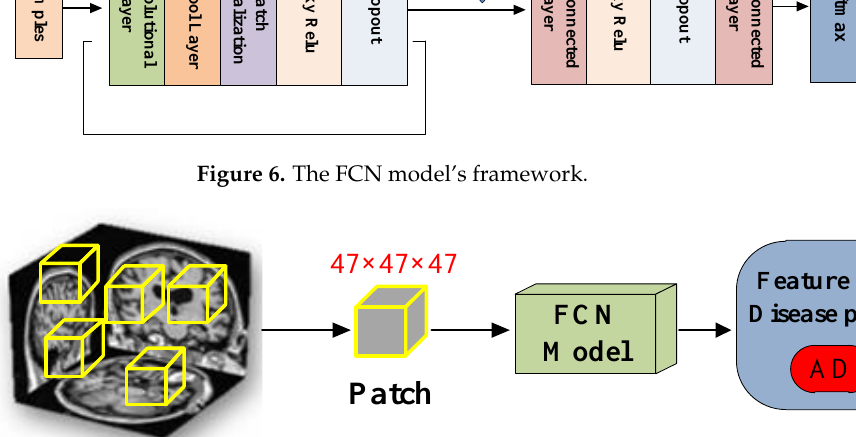
Figure 7. Randomly sampling 3D-MRI image’s patches for training the FCN Model.